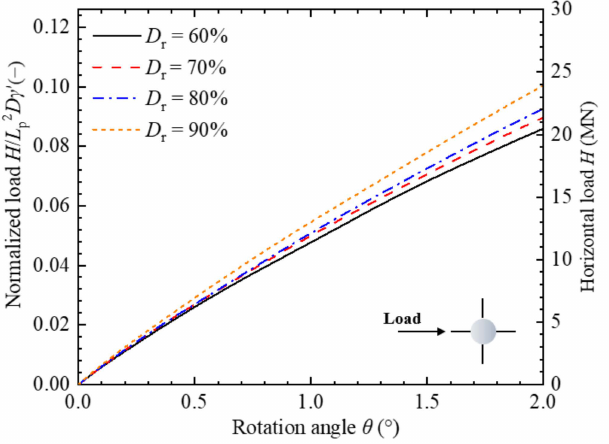
Figure 16. Load–displacement curves of winged monopiles in sand with different relative densities ( D r ).